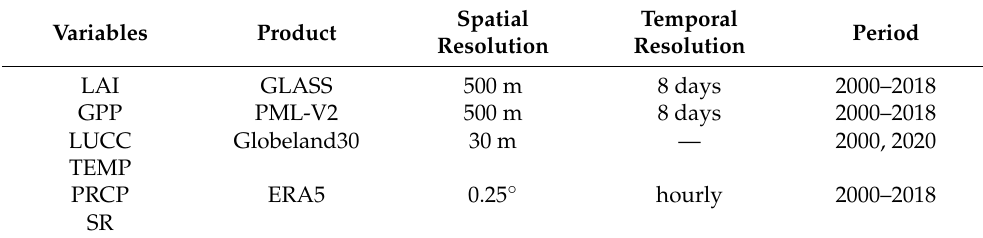
Table 1. Satellite products and reanalysis data used in this study. Variables Product